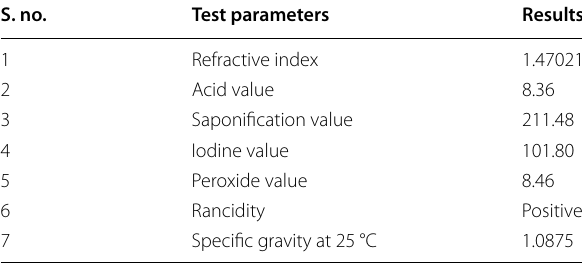
Table 1 Physicochemical parameter of Anu Taila formulation S. no.